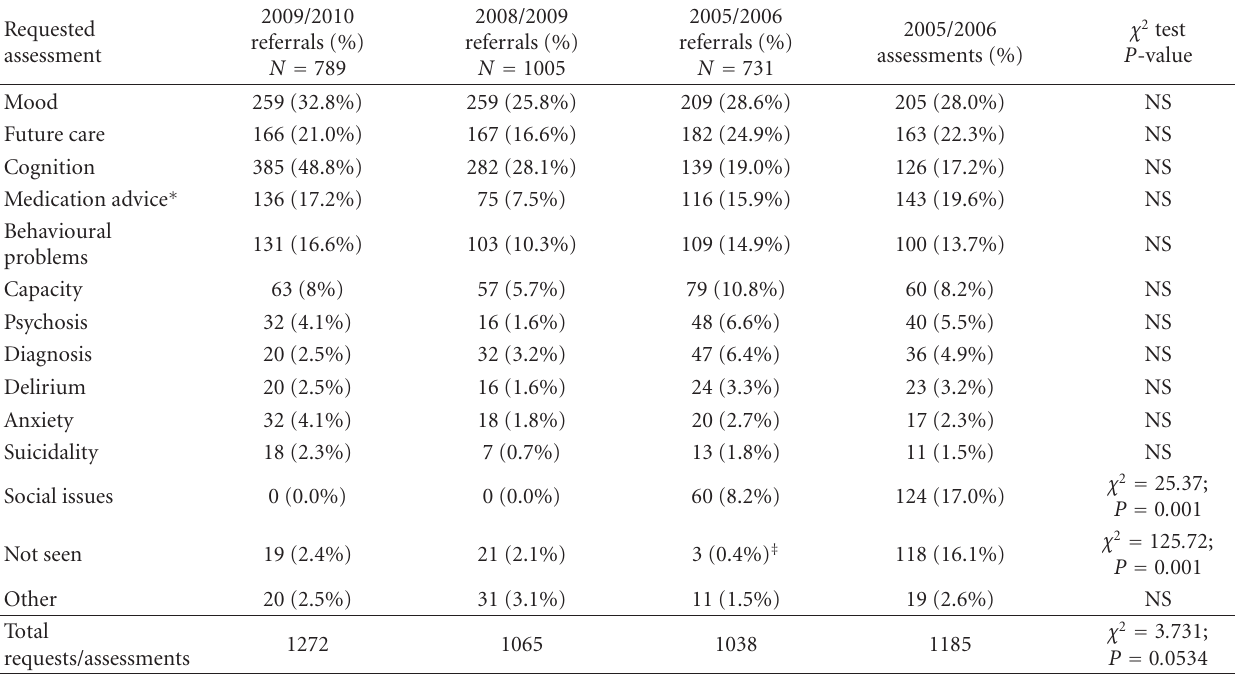
Table 3: Reasons for referrals and completed assessments. ‡ Discharged before referral received. Please note that the statistical analysis refers only to the referred and assessed rates for 2005/2006 year. For this, we have used nonparametric analysis (Chi-square test) to test for the di ff erences between referred and assessed sample proportions. Only significant values are presented in the table. N refers to number of